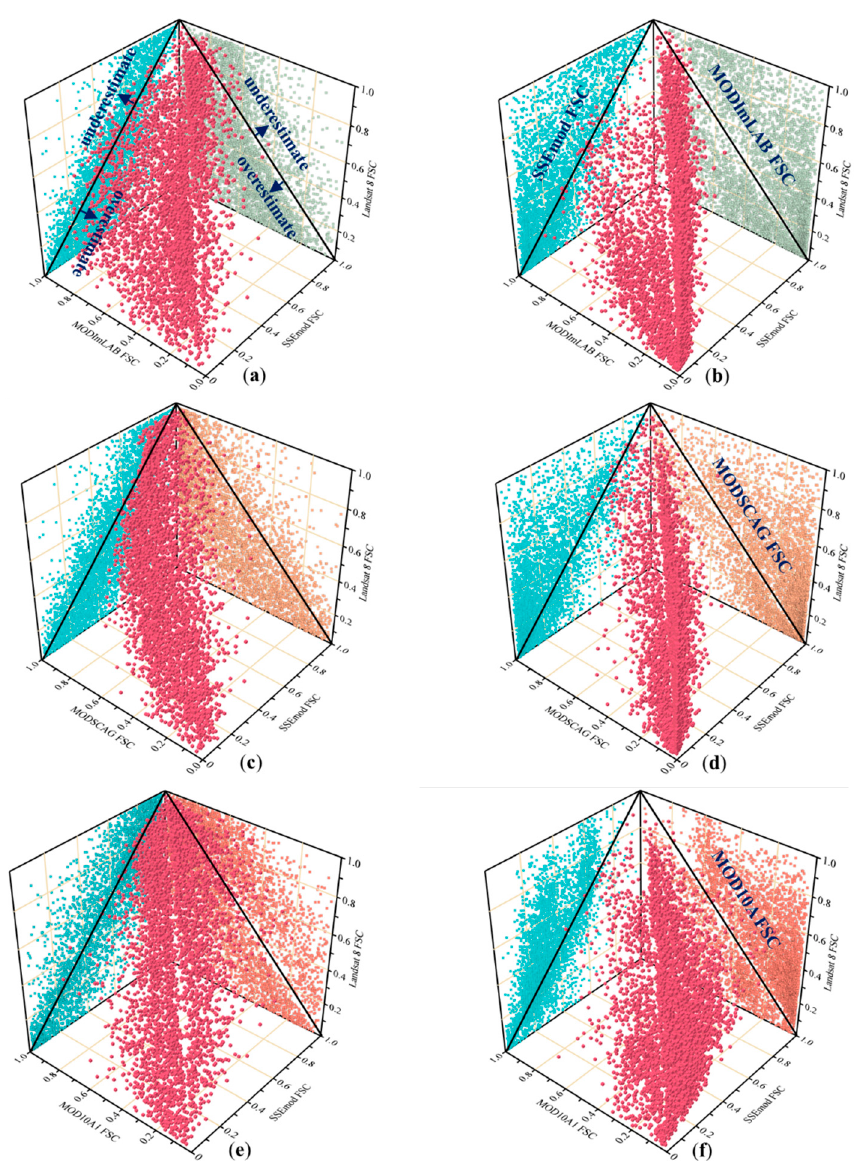
Figure 10. The accuracy validation of SSEmod FSC, MODImLAB FSC, MODSCAG FSC, and MOD10A1 FSC in the forest and non-forest areas. SSEmod FSC is projected onto the X–Z plane, and other FSC products are projected onto the Y–Z plane, respectively. ( a , c , e ) are the validation results in non-forest areas. ( b , d , f ) are the forest areas’ validation results. Table 2. The accuracy validation of binary and fractional metrics of FSC retrieved by the spectral mixture analysis models and semi-empirical linear model in forest areas and non-forest areas of the three main snow-covered regions of China.